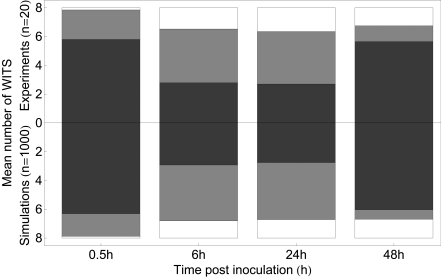
Comparison of the Observed and Predicted (Model) Frequency and Colocalisation of WITS in the OrgansShowing the mean number of WITS present in the spleen and liver (dark grey), one organ only (light grey), and neither organ (white). Experimental data are presented above the horizontal time line. The WITS frequencies as predicted by the modelling are presented below the horizontal time line (described in detail in Protocol S1, Models Section 3).